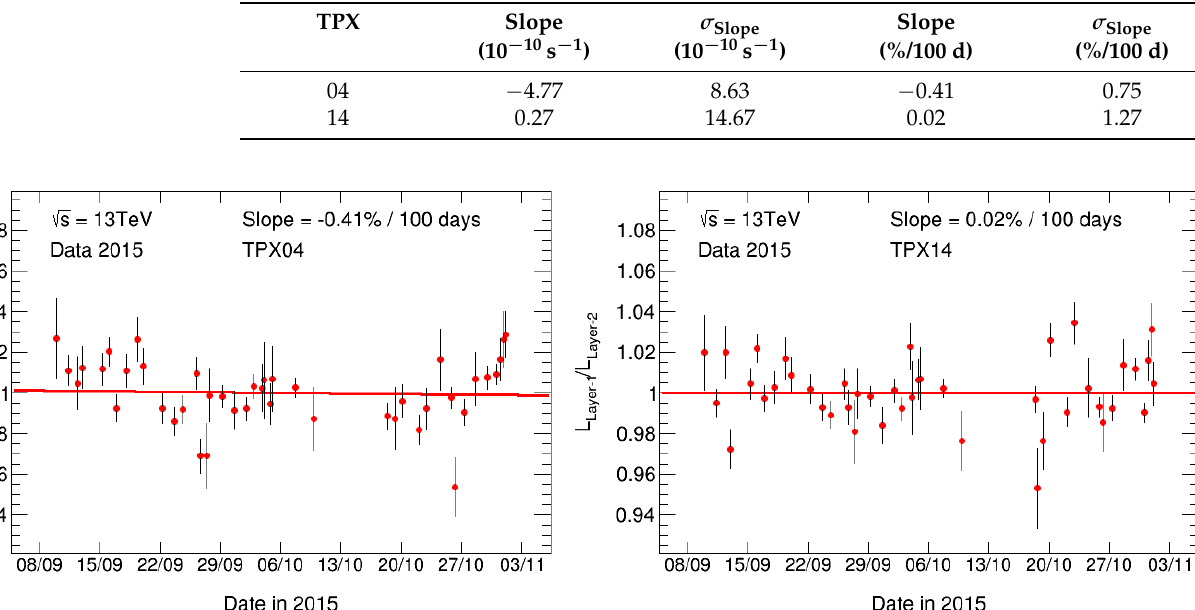
Figure 55. Time history of the luminosity ratio measured by layers 1 and 2 for TPX04 and TPX14. The 2015 TPX data are divided into luminosity blocks of typically one minute length and then grouped into LHC fill time periods. The statistical error bars are given. A linear fit is applied to determine the slope. The LHC fills from September to November 2015 are shown. Taken from Ref.